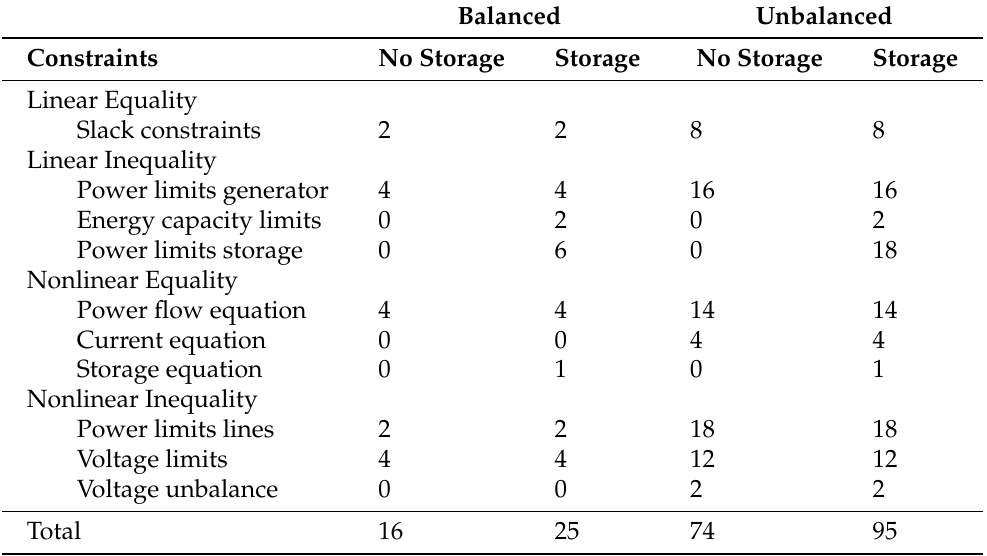
Table 2. Number of